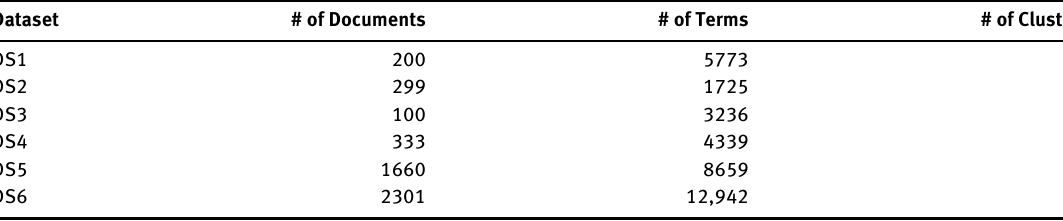
Table 2: Description of the Selected Text Documents (Data Sets)